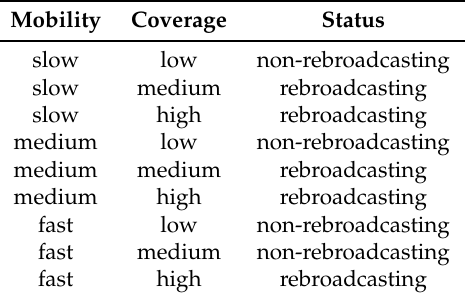
Figure 5. Rebroadcast module fuzzy membership functions. Table 1. Fuzzy Rules of